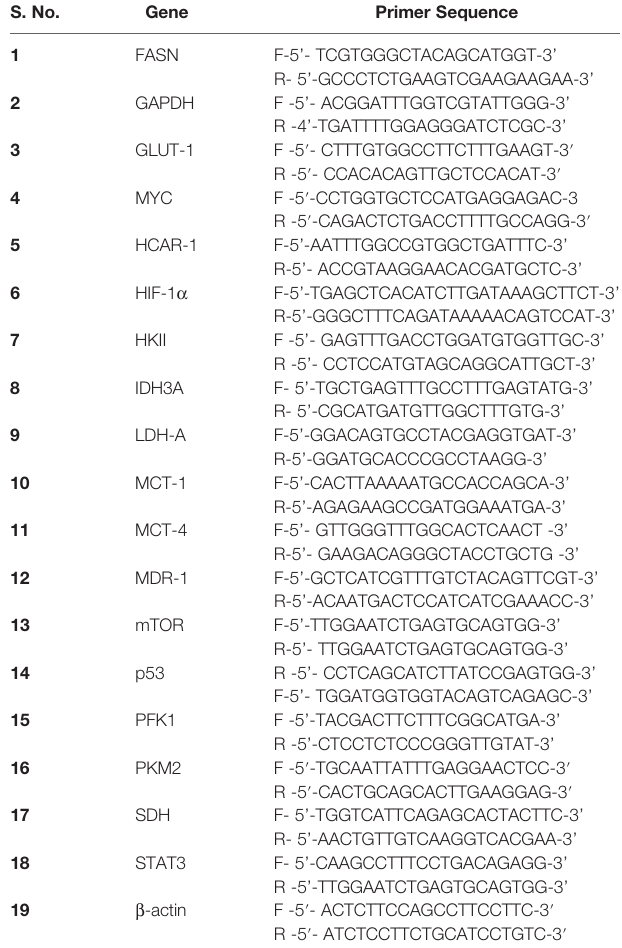
TABLE 1 | Primer sequences for RT-PCR